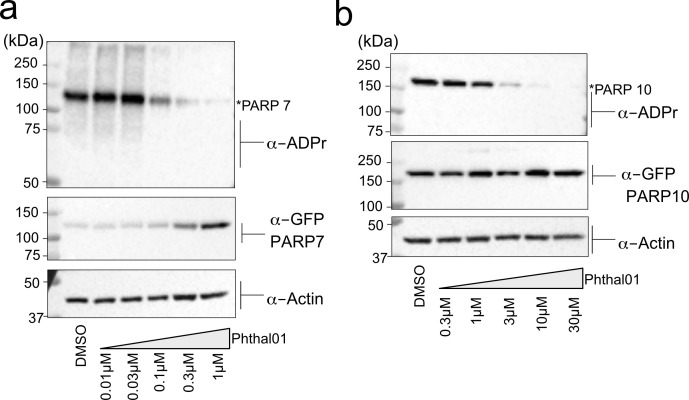
Phthal01 inhibits PARP-7, and at much higher concentrations, PARP-10-mediated MARylation in cells.(a) HEK 293 T cells expressing GFP-PARP-7 were treated with increasing concentrations of Phthal01 for 16 hr. Proteins were resolved by SDS-PAGE and were detected by Western blot using antibodies against ADPr, GFP, and actin. (b) HEK 293 T cells expressing GFP-PARP-10 were treated with increasing concentrations of Phthal01 for 16 hr. Proteins were resolved by SDS-PAGE and were detected by Western blot using antibodies against ADPr, GFP, and actin.